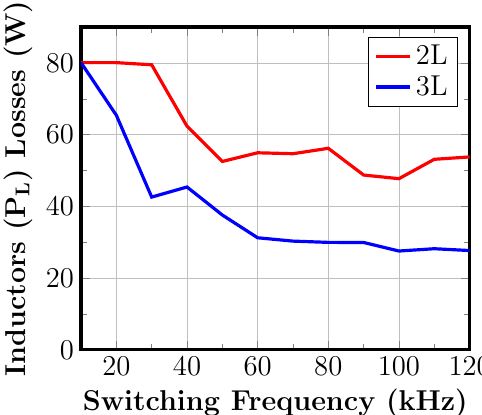
Figure 18. Total inductor losses as function of the switching frequency. The design constrain was to maintain the current ∆ I pp constant to 13.4